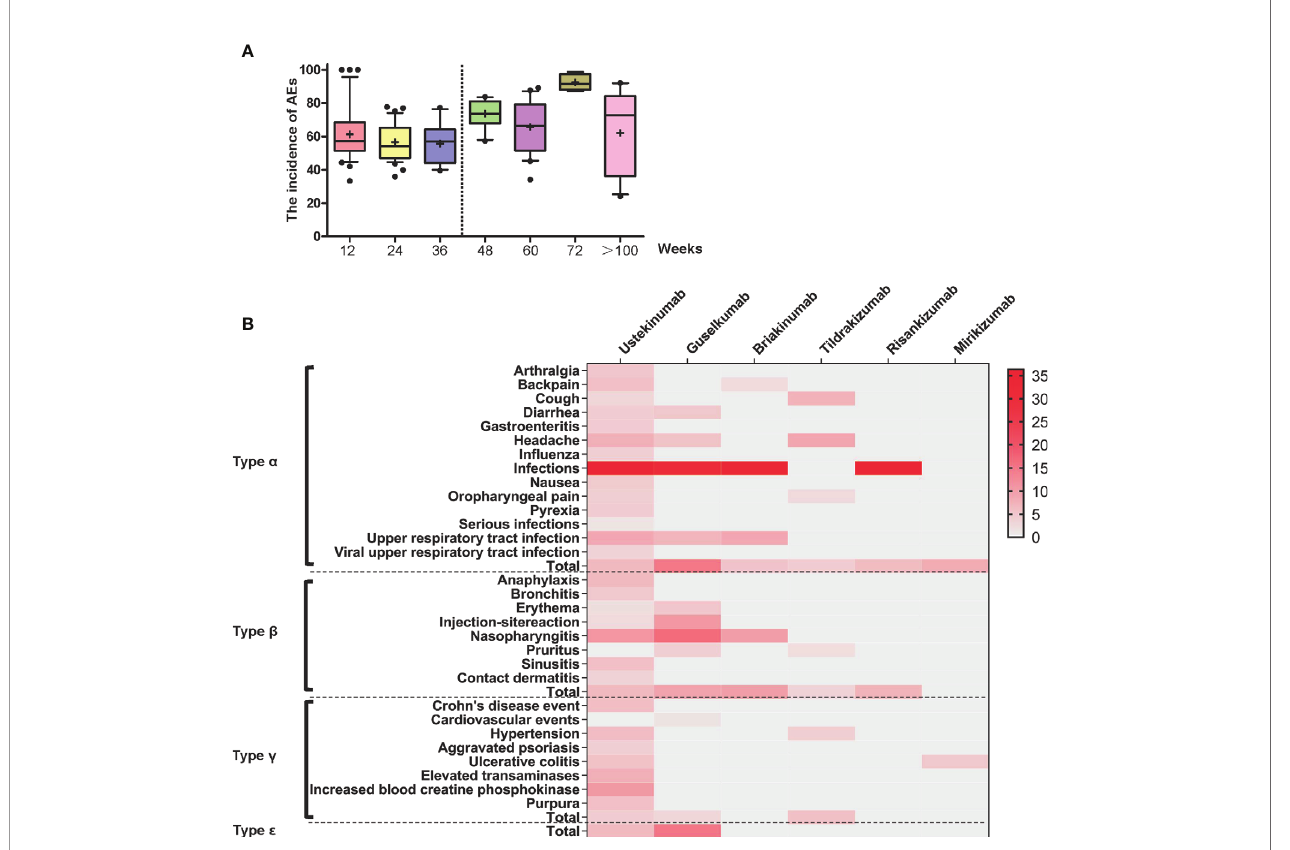
FIGURE 1 | (A) Box diagram for subgroup analysis. Box diagram for the incidence of changes in adverse events with different medication courses. (B) Heat map of different types of symptoms caused by different drugs. Red areas indicate greater relative probability of occurrence and lighter colored areas indicate a slight or null relative probability of occurrence. All data included in the heat map are statistically signi fi cant ( P <